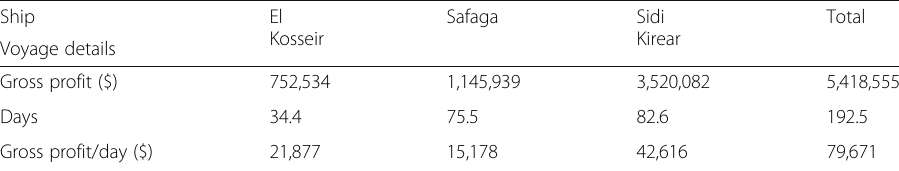
Table 7 Voyage details reported by the model (with gross profit per day objective) for each ship, at high